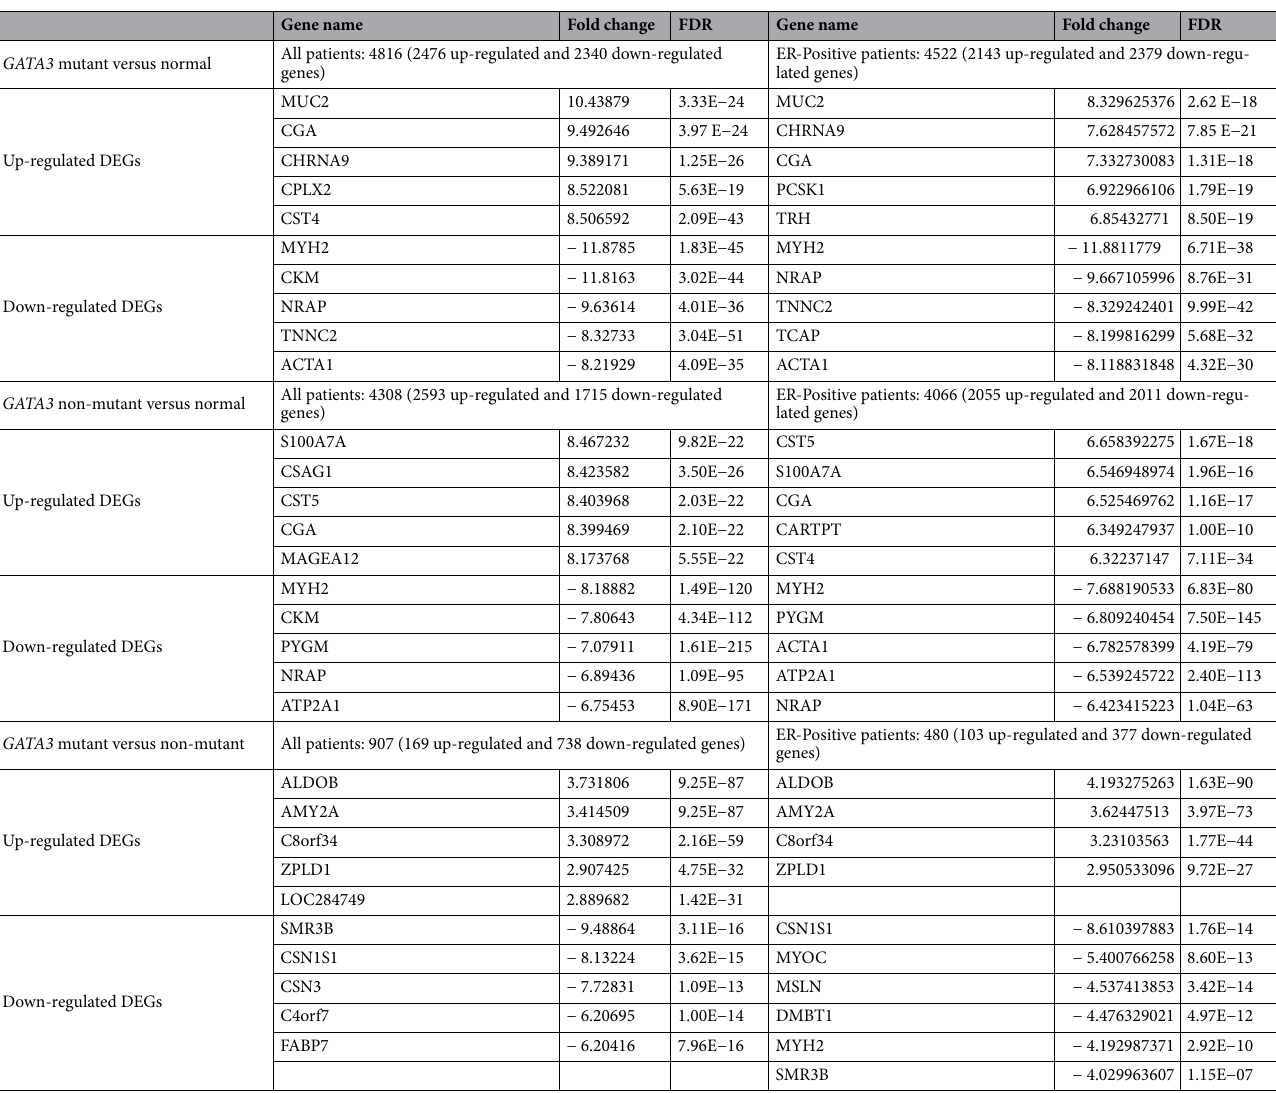
Table 4. Differentially expressed genes (DEGs) between GATA3 -mutant versus normal and GATA3 -non- mutant versus normal and GATA3 -mutant versus non-mutant tissues according to the TCGA